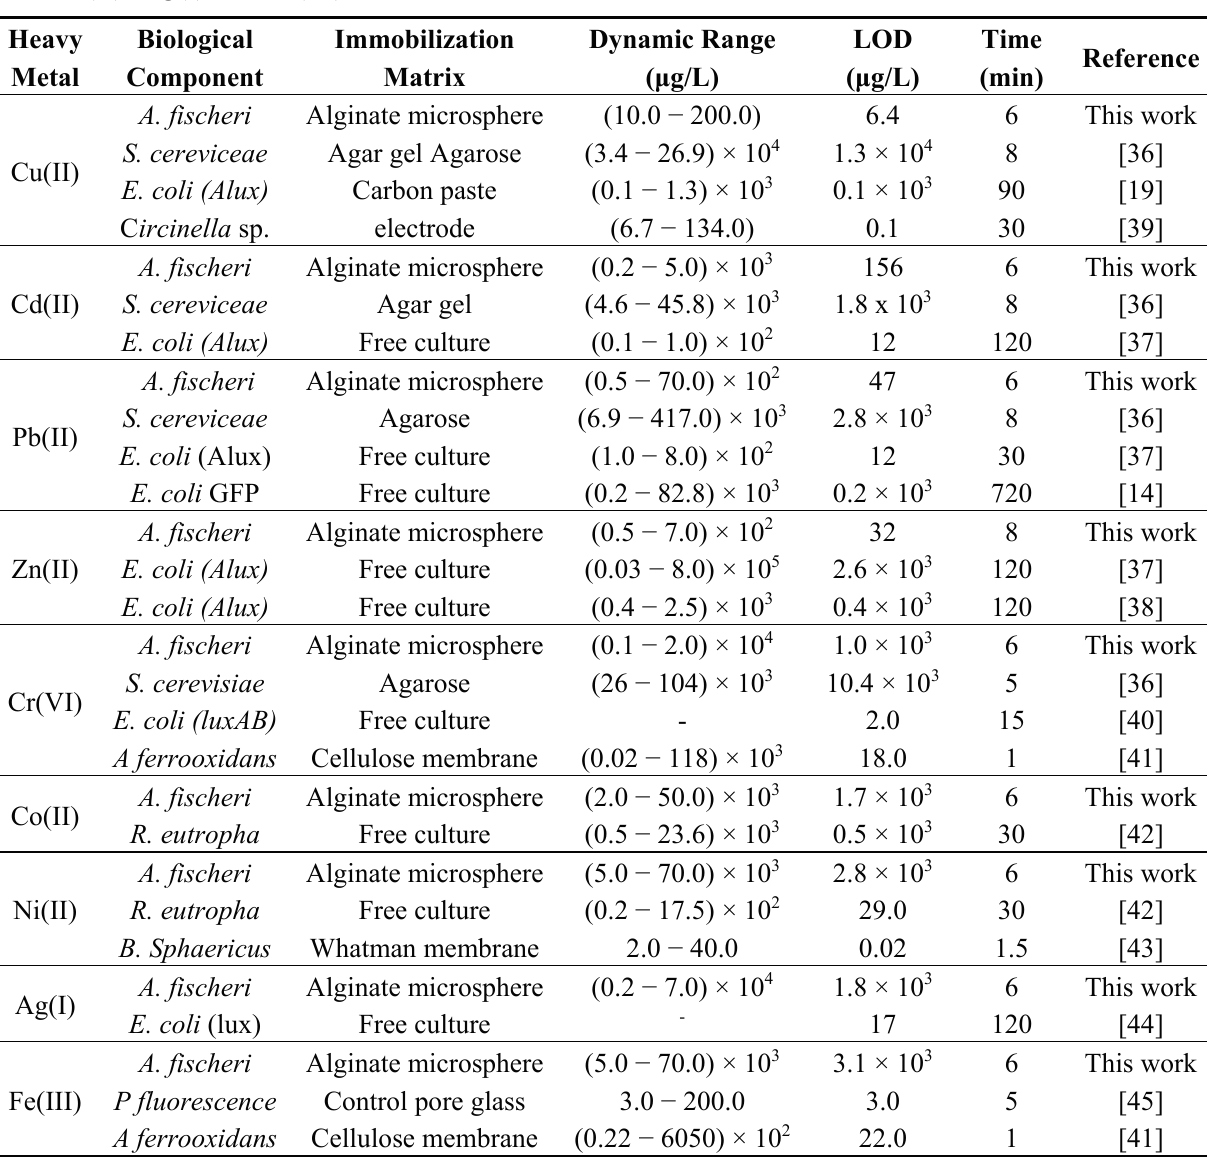
Table 3. Comparison of the developed toxicity biosensor performance with other reported toxicity biosensor for the determination of Cu(II), Cd(II), Pb(II), Zn(II), Cr(VI), Co(II), Ni(II), Ag(I) and Fe(III)